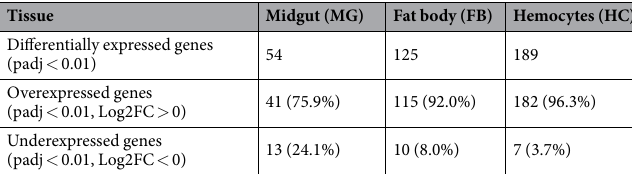
Table 1. Differentially expressed genes per condition at 15